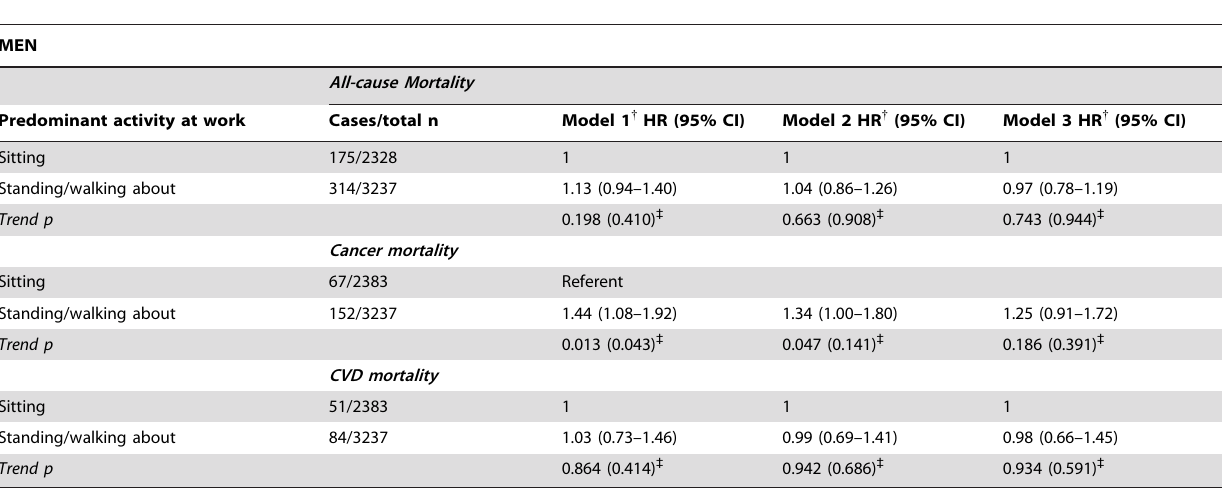
Table 3. Cox regression models for main activity while at work and all-cause/cancer/cardiovascular mortality in men aged $ 40 years who were in employment at baseline